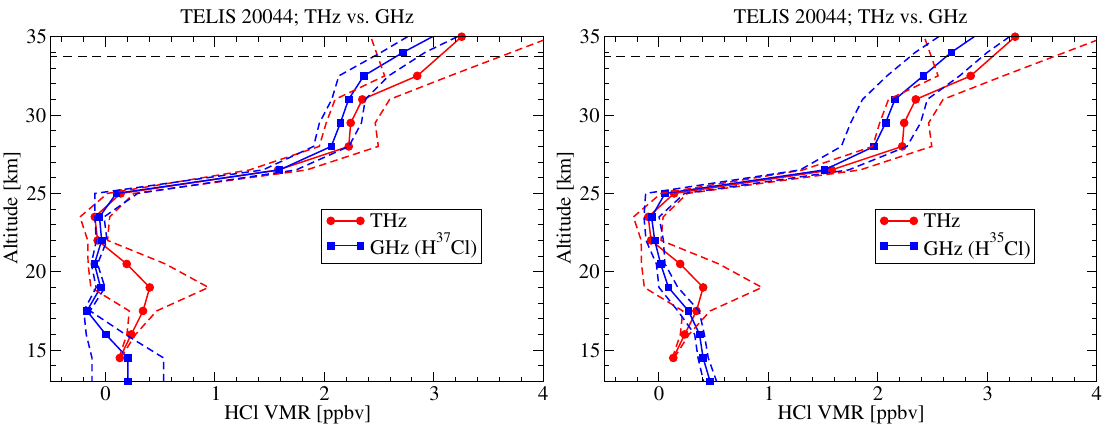
Figure 8. Comparison of HCl retrievals in the two channels of TELIS. The measurements have the same identifier (20044) and the two submillimeter profiles are derived from two different isotopes, i.e., H 37 Cl and H 35 Cl,